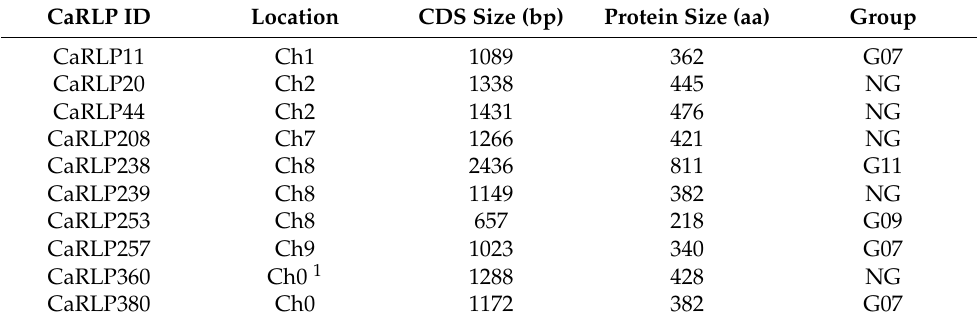
Table 1. Information for VIGS (virus-induced gene silencing) analysis of 10 selected CaRLPs ( Capsicum annuum receptor-like proteins).